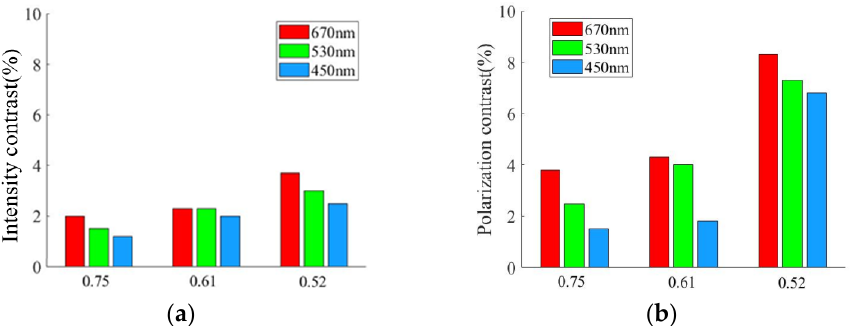
Figure 13. Contrast of multi-band images with different sea fog visibility ( a ) Intensity image; ( b ) Polarization image.